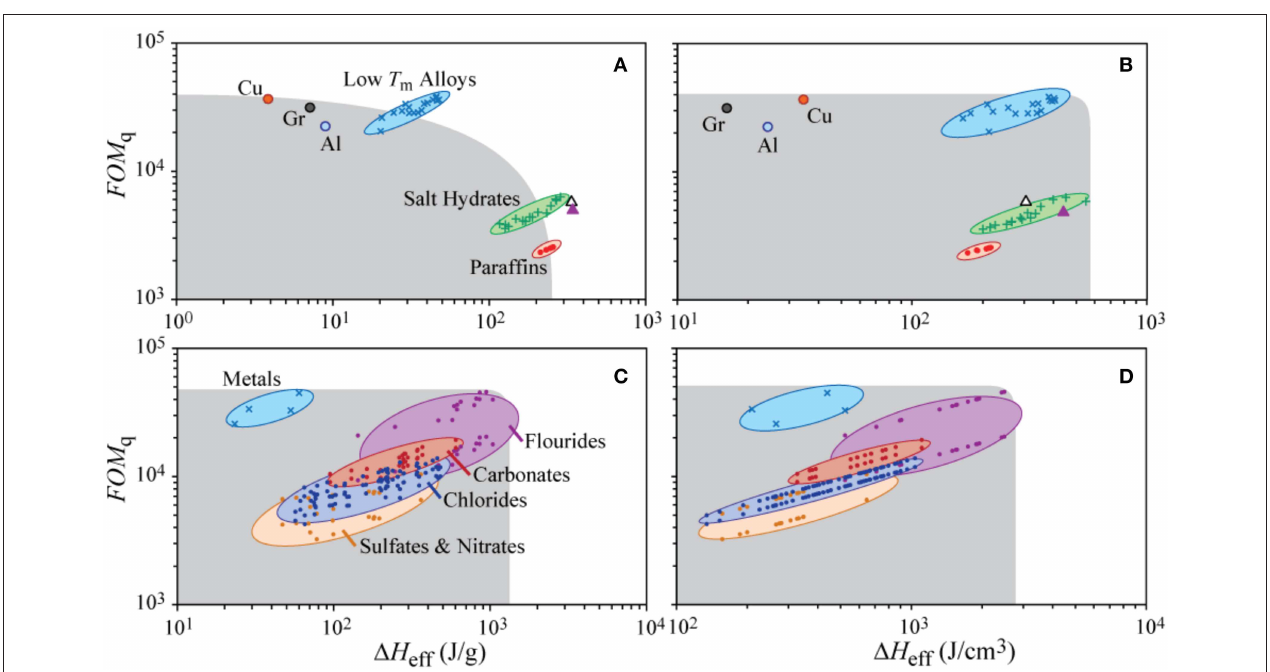
0.01m. Material properties are typical for paraffin wax ( Table 1 ) = 0.5 and 0.0. =